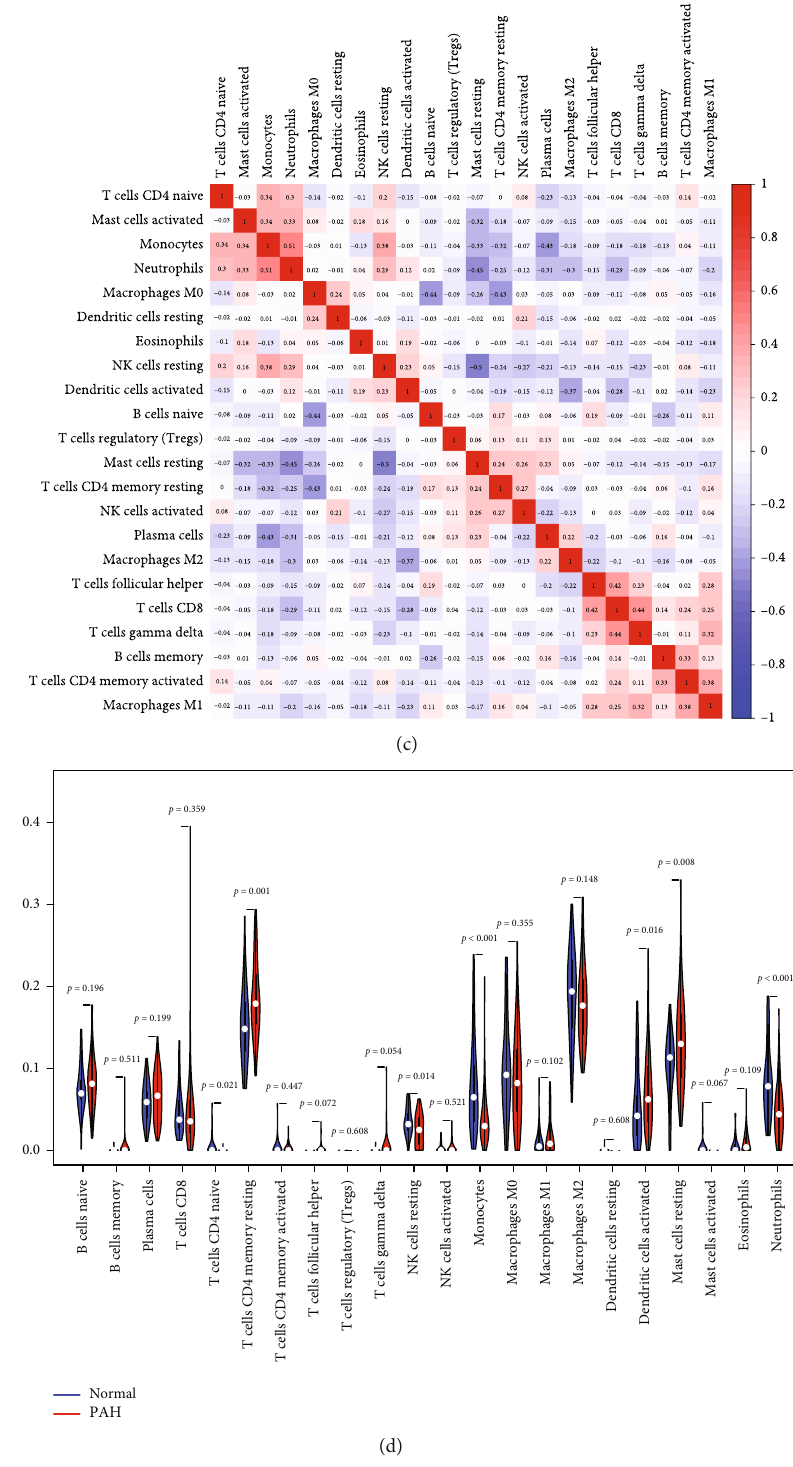
Figure 10: Comparing the composition of immune cell in fi ltration in the normal and PAH samples by using the combined data matrix of GSE113439 and GSE117261 and visualized the results. (a) PCA cluster plot of immune cell in fi ltration between normal and PAH samples. (b) The heat map of the 22 subpopulations of immune cells. (c) Correlation heat map of 22 types of immune cells. The size of the colored squares represents the strength of the correlation: red represents a positive correlation; blue represents a negative correlation. The redder the color, the stronger the correlation. (d) Violin diagram of the proportion of 22 types of immune cells. (The normal samples are marked as blue color and PAH samples marked as red color. P values < 0.05 were considered as statistically signi fi cant.) PAH: pulmonary arterial hypertension; PCA: principal component